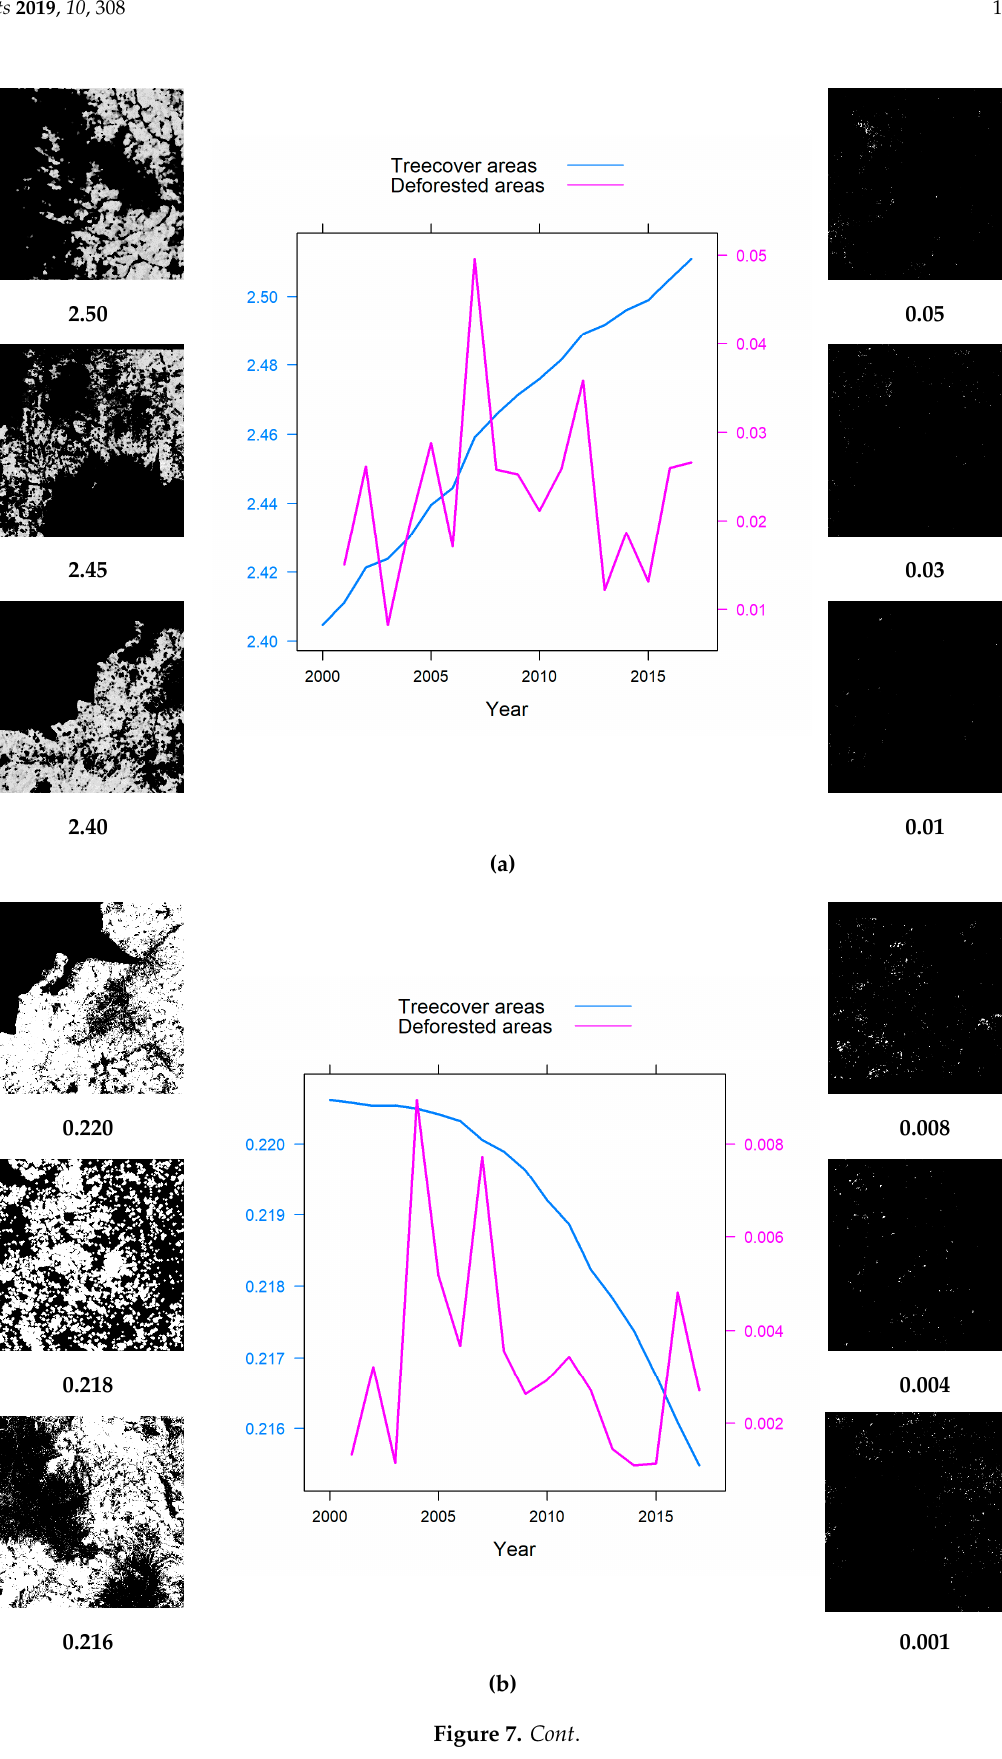
( d ) Figure 6. Hexbin plot revealing a 2 ‐ dimension spatial distribution of ( a ) number of companies; ( b ) number of employees; ( c ) values of profit; ( d ) values of turnover, where the color ‐ scheme defines the abundance of values. 3.3. The Analysis of GLCM Entropy